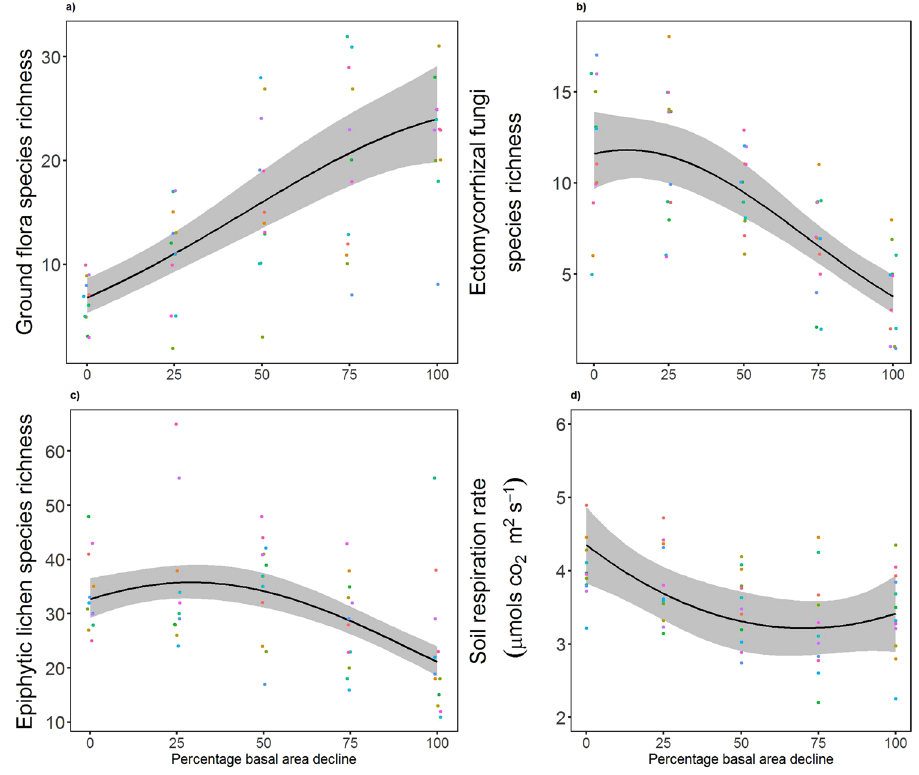
Figure 2. Threshold relationships between stage of dieback and species richness and soil respiration rate. Relationships between stage of dieback and species richness of ( a ) vascular ground flora (n = 60); ( b ) ectomycorrhizal fungi (n = 60); ( c ) epiphytic lichen (n = 60); and ( d ) soil respiration rate (n = 60). The black lines represent prediction using the most parsimonious model coefficients and grey shading the 95% confidence intervals of the coefficients (marginal r 2 = 0.60, 0.57, 0.44, and 0.16 for ( a–d ), respectively). The different coloured points represent the values at each individual site. All species richness values are the number of unique species found in 0.04